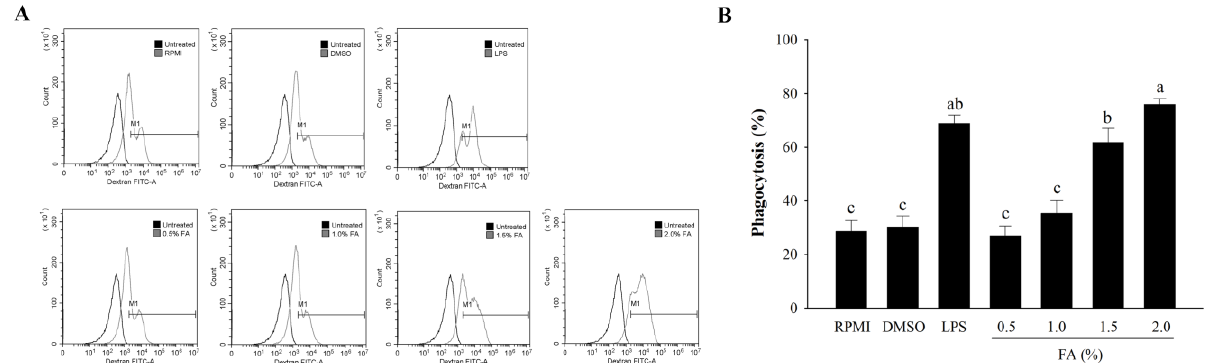
Figure 5. The effect of HAGF on the phagocytosis of macrophages. ( A ) Fluorescence histograms of FITC – dextran uptake. ( B ) The percentage of phagocytic activity. Values are shown as means ± SD ( n = 3). Different letters (a – c) are used to reflect statistical differences at p < 0.05. M1 = An immune stimulation activity-related macrophage phenotype. FA = fatty acid.